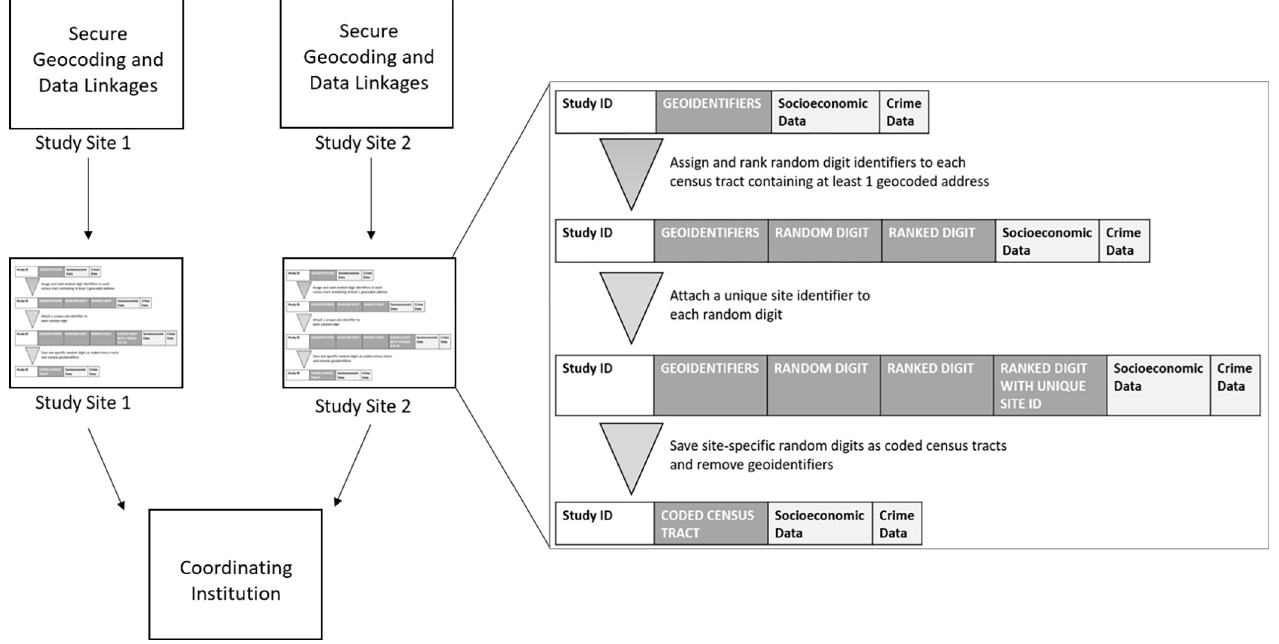
Fig 2. Process for creating coded census tracts during multisite study. Process for stripping census tracts containing geocoded patient address information of their census-designated identifiers and assigning a randomly generated number to create anonymized “coded” census tracts. The design of Fig 2 was adapted from a figure published by Brokamp et al., 2018 in the open-access journal J Am Med Inform Assoc [51].